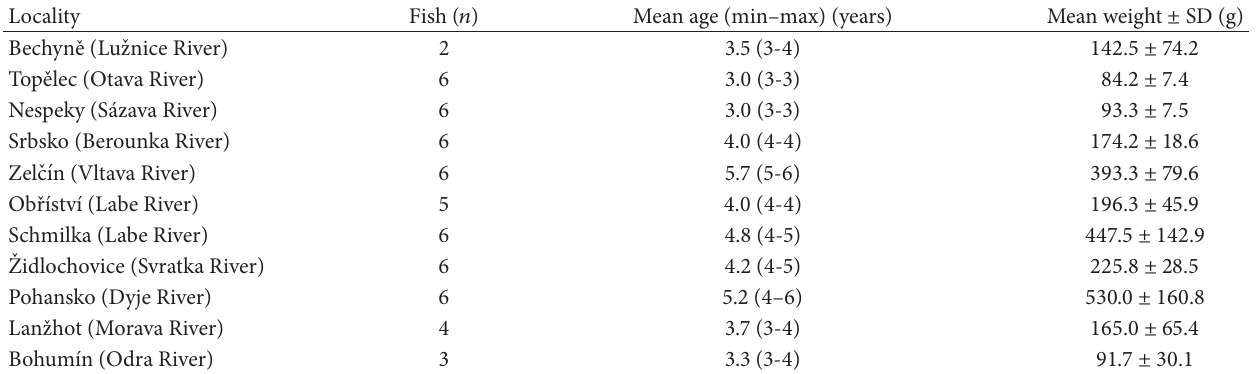
Table 2: Biometric c haracteristics of male chub from sampling sites.